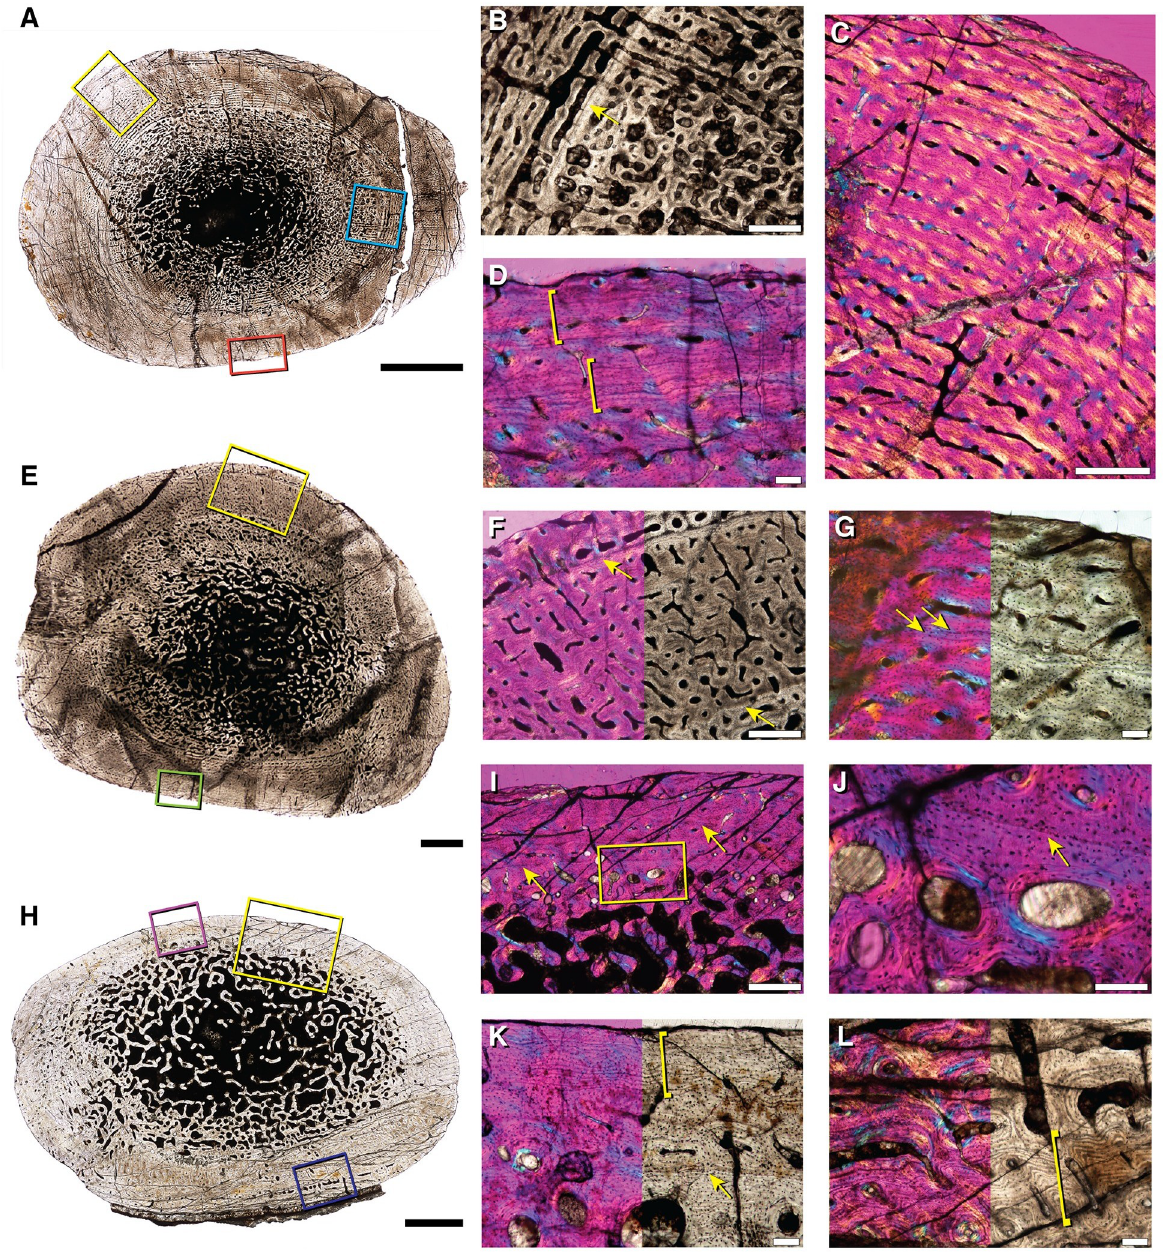
Fig 4. Bone histology of associated hind limb elements of Lystrosaurus sp. representative of Size Class III. A , femur (IVPP V 27125a) with a deep cortical LAG in B (blue box in A ). The outer cortex has regions of high vascularity seen in C (yellow box in A ), and regions marked by a nearly continuous peripheral growth mark of parallel-fibered tissue (denoted by yellow brackets) in D (orange box in A ). E , tibia (IVPP V 27125b) has two cortical growth marks seen in F (yellow box in E ; yellow arrows in F ). The outer growth mark can variably be seen as a double LAG in G (green box in E ; yellow arrows in G ). H , the fibula (IVPP V 27125c) has a thinner cortex interrupted by two LAGs seen in I (yellow box in H ; yellow arrows in I ). J , magnification of yellow box in I shows the cross-cutting inner cortical LAG (arrow in J ). K , thinner regions of the cortex appear avascular (purple box in H ), with stacked mineralized lamellae of parallel-fibered bone (yellow bracket), whereas thicker regions (dark blue box in H ) show peripheral pulses of vascularized growth, within the lamellated tissue, seen in L (yellow bracket). Scale bars = 5 mm in A , 1 mm in E , 2 mm in H , 500 μ m in B , C , F & I , and 100 μ m in D , G , J — L .